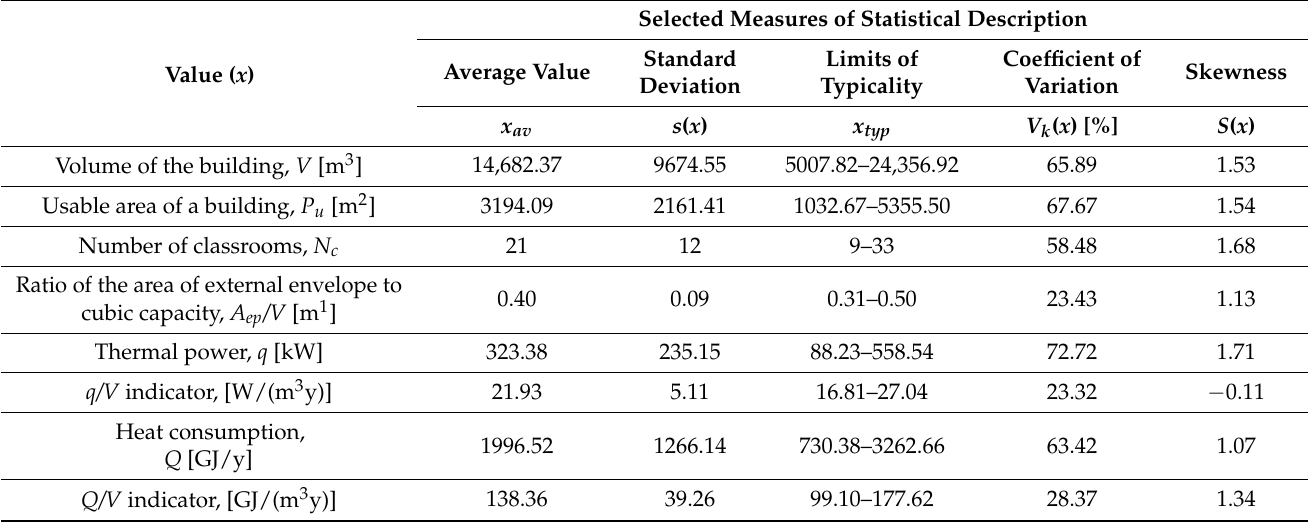
Table 1. Selected measures of statistical description for the values characterising 50 education buildings.